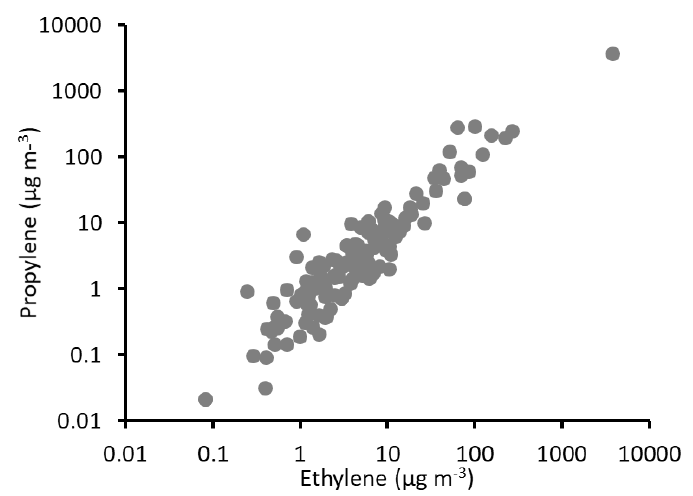
Figure 7. Ethylene versus propylene in all portable station measurements. Both axes are shown in log scale.